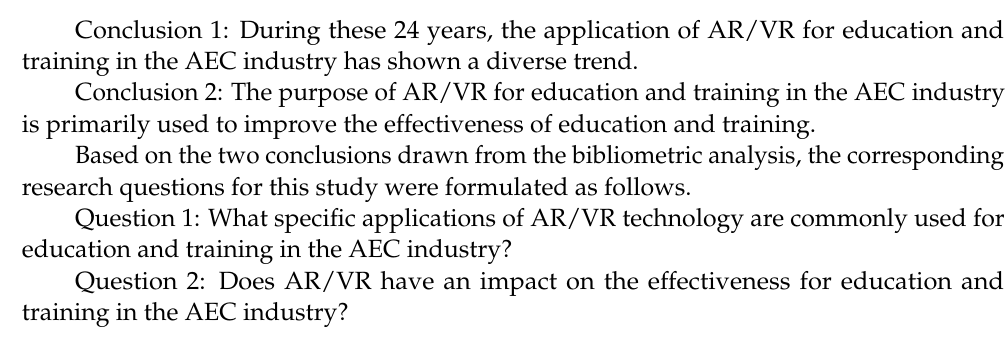
Figure 8. The relationship between the main item and other items.